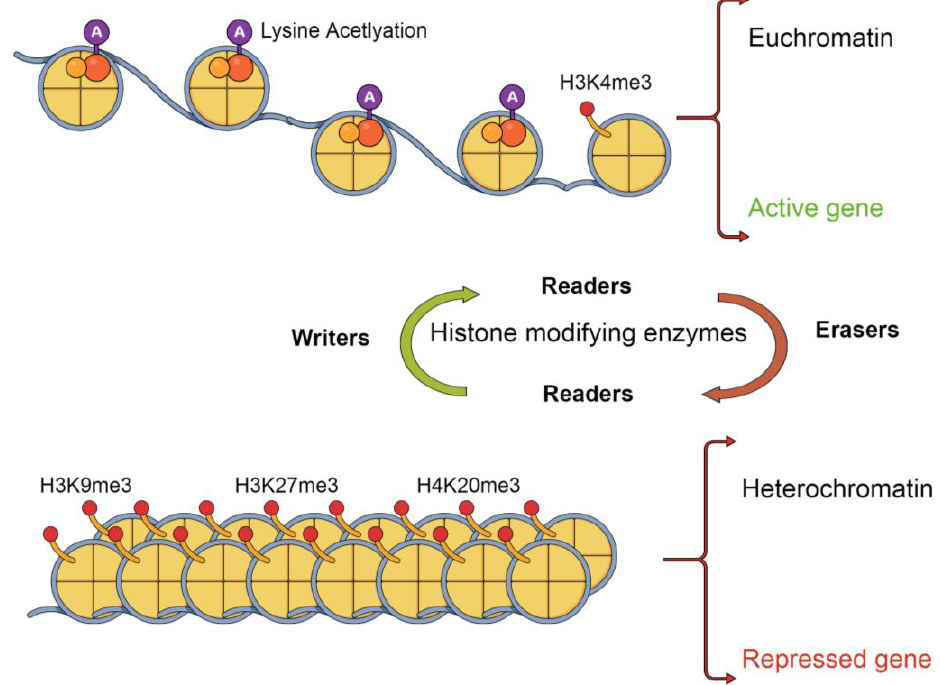
Figure 2. Posttranslational modifications of histones regulate gene expression. Effects of posttranslational modifications on gene regulation. Writers add posttranslational modifications, readers read the posttranslational modification landscape influencing further decisions and Erasers remove posttranslational modifications. TTS: transcription start site.